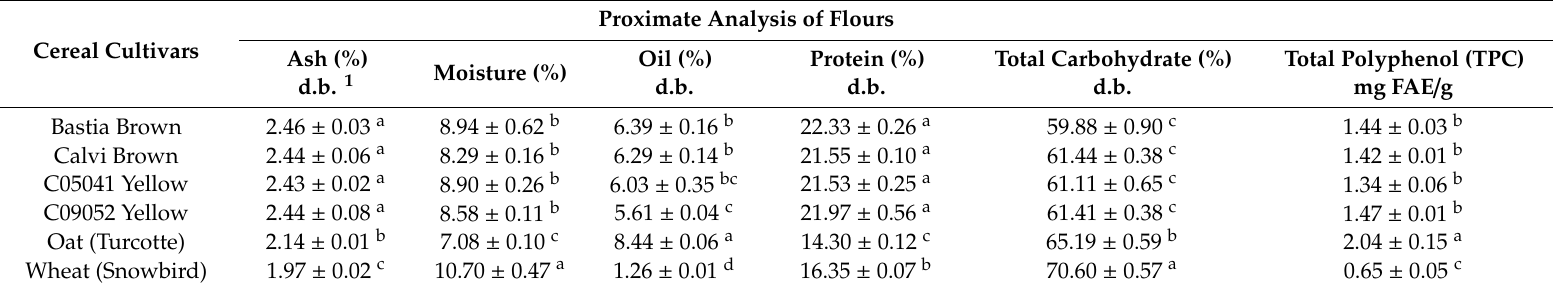
Table 1. Proximate composition of di ff erent dehulled hairless canary seeds, oat and wheat